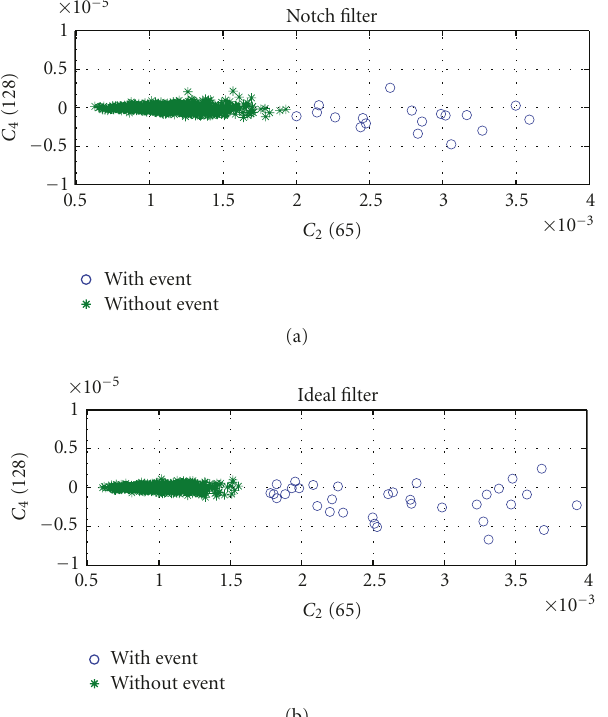
Figure 6: HOS-based features extracted from voltage signals whose frame length is equal to N = 32. While second-order statistics are extracted from f , the fourth-order statistic is extracted from u .